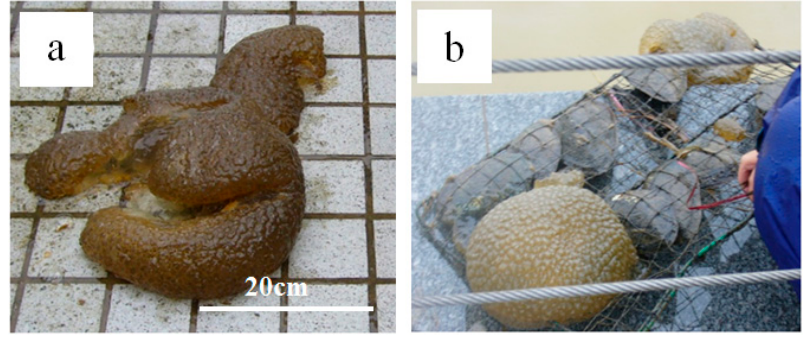
Figure 2. Cont. Figure 2. Cont